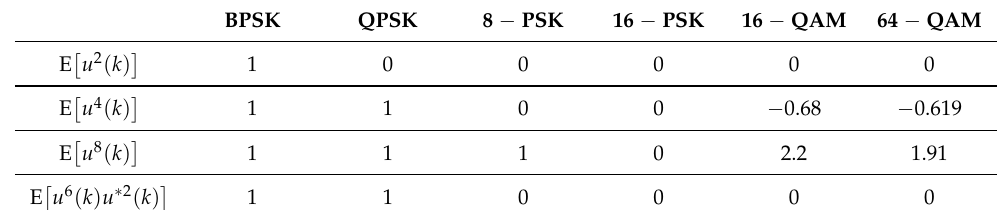
Table 1. Higher order expectations for different modulation schemes with unit